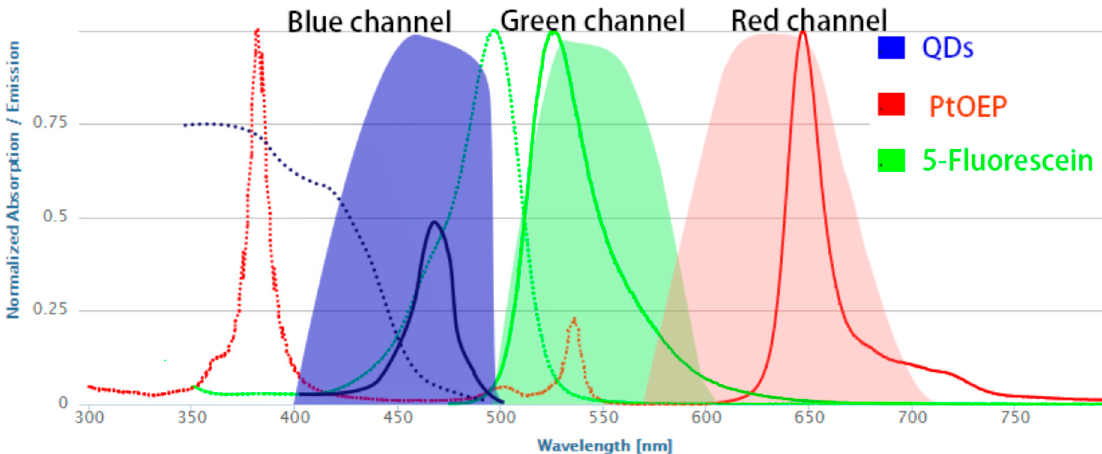
Figure 3. Spectra of the dyes (absorption in dashed and emission in solid lines), and the spectral range of three different channels (red, green, and blue) in JAI AT-200GE 3CCD camera. The emission intensity of the three dye materials (PtOEP, 5-Fluorescein, and QDs) respectively was recorded by the corresponding three spectrum channels (red, green, and blue) of the 3CCD camera. The pixel intensity of the red, green channel was dominated by the luminescence from the